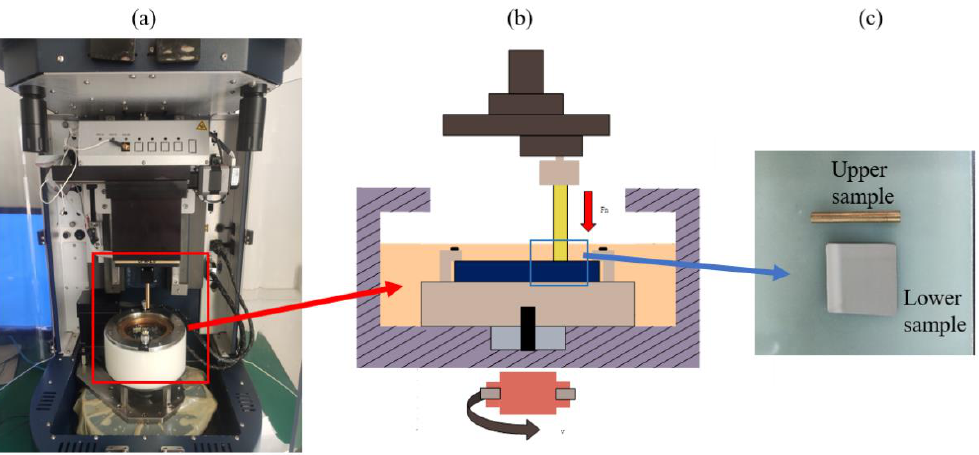
Figure 3. Scheme of the experimental apparatus. ( a ) The friction test machine (UMT-3, BRUKER, Rheinstetten, Germany), ( b ) the Schematic diagram of the pin-on-disk experimental device, and ( c ) sample pin and disk.